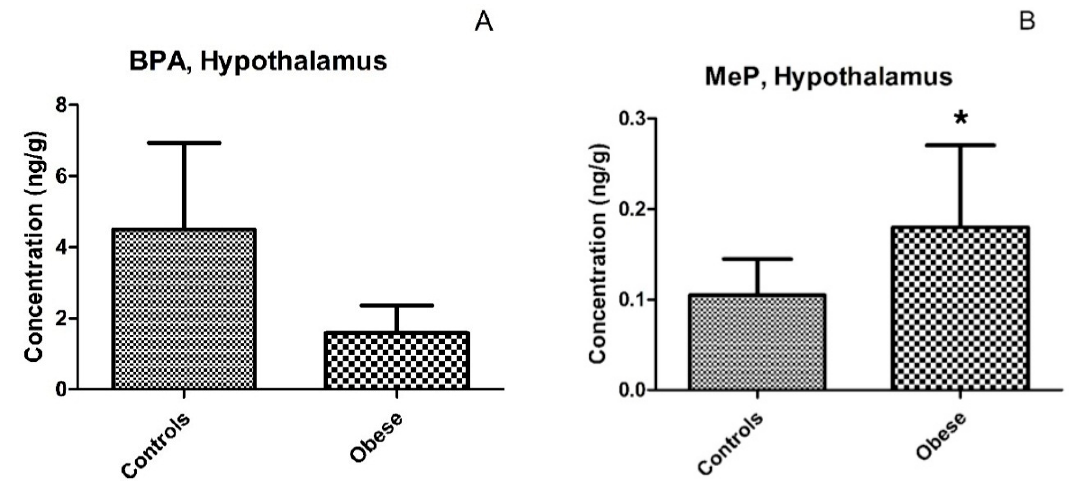
Figure 4. Concentrations (mean ± SD) of bisphenol A (BPA) ( A ) and methyl paraben (MeP) ( B ) in paired hypothalamus tissues from controls ( n = 12) and obese individuals ( n = 12). * ‐ p < 0.05 .